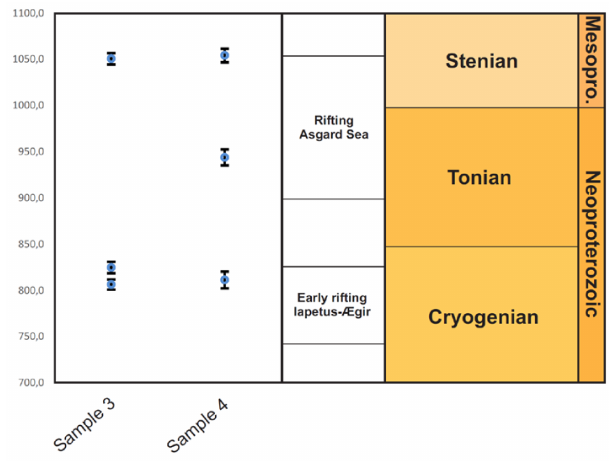
Figure 5. Graph displaying the obtained Precambrian ages for brit- tle faults in the Alta–Kvænangen tectonic window. The vertical axis is time in Ma and the horizontal axis shows the dated sample num- bers, whose locations are displayed in Figs. 1 and 4. Columns to the right show extensional tectonic events related to the formation of the NW Baltoscandian basins during the opening of the Asgard Sea (Siedlecka et al., 2004; Nystuen et al., 2008; Cawood et al., 2010; Cawood and Pisarevsky, 2017) and to the earliest phase of rifting of the Iapetus Ocean–Ægir Sea (Li et al., 1999, 2008; Torsvik and Rehnström, 2001; Hartz and Torsvik, 2002), and associated geolog- ical periods and